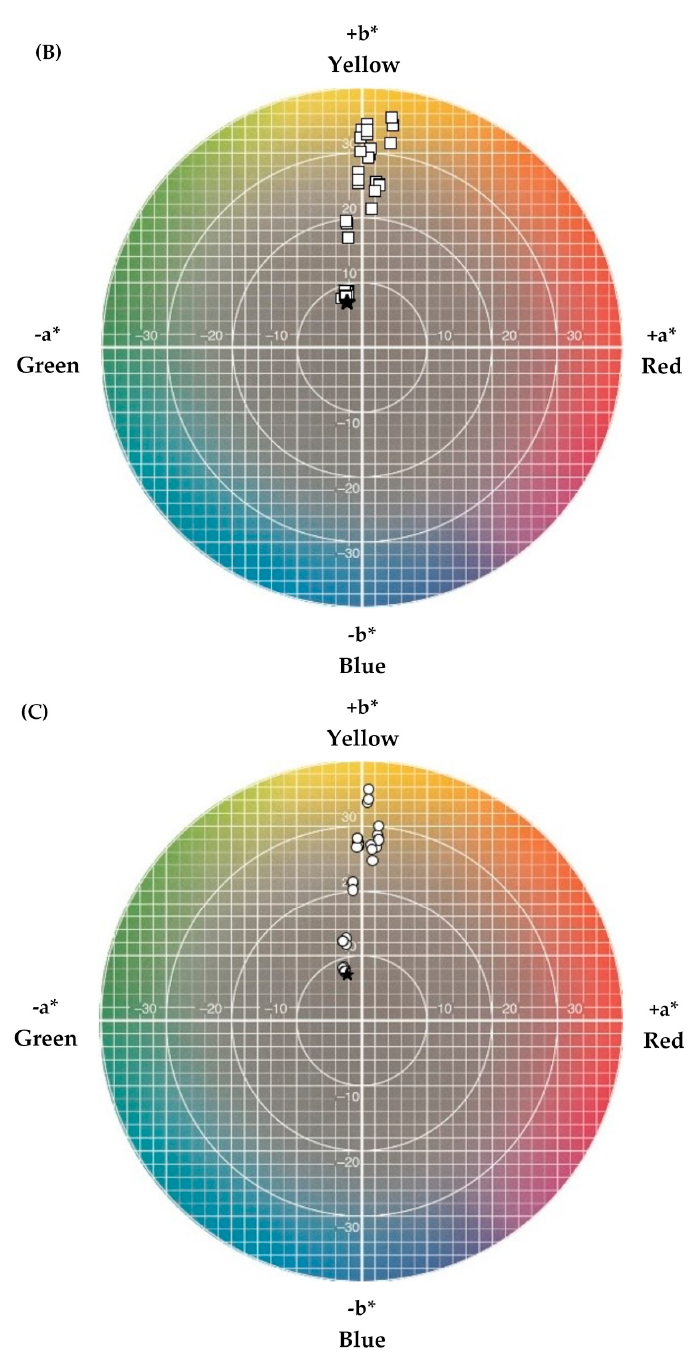
Figure 1. The color positions in the Compagnie Internationale de l’Eclairage (CIE) L*a*b* colorimetric system of Arthrobacter arilaitensis Po102 cultures cultivated on 3 kinds of deacidified cheese-based solid media. ∆ = color on CM NaOH ( A ); □ = color on CM Dh304 ( B ); ○ = color on CM Km44 ( C ); and = color of blank agar (without inoculating with A. arilaitensis Po102).